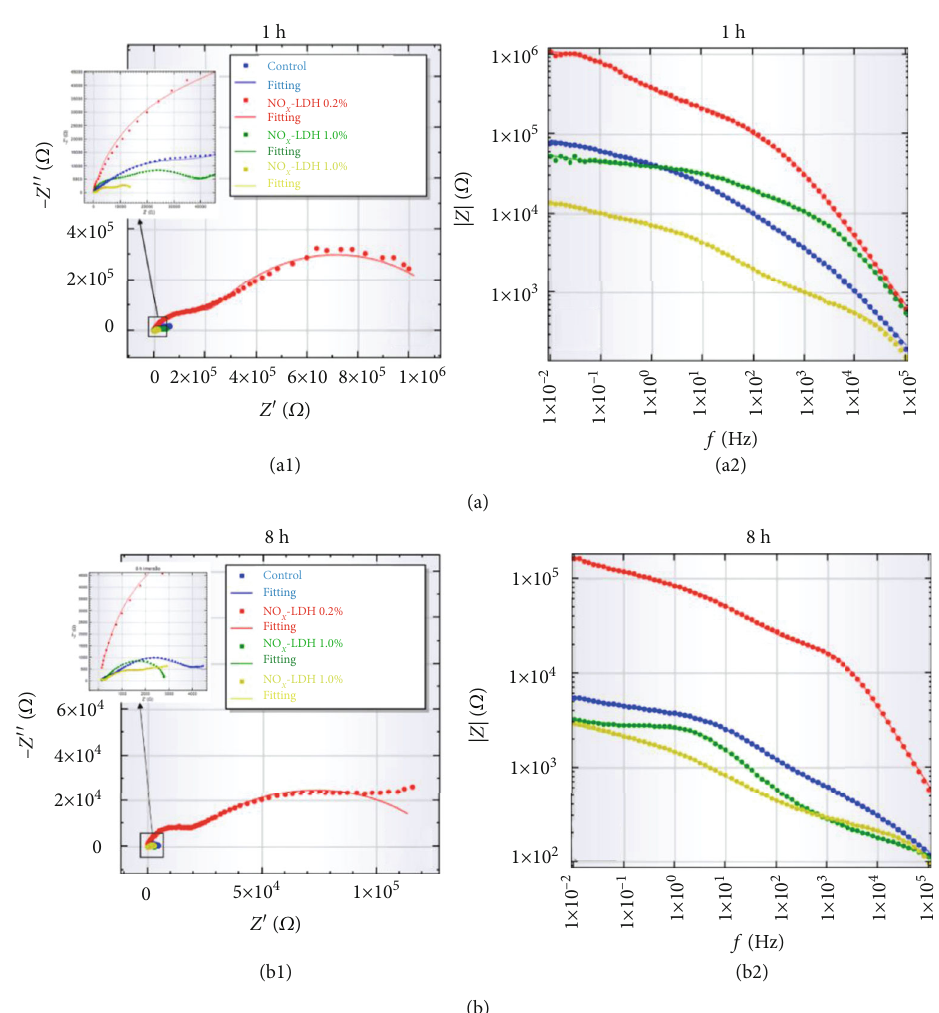
Figure 15: Nyquist plots (1) and Bode modulus plots (2) for coated systems after (a) 1h and (b) 8h of immersion (exposed area: 17 cm 2